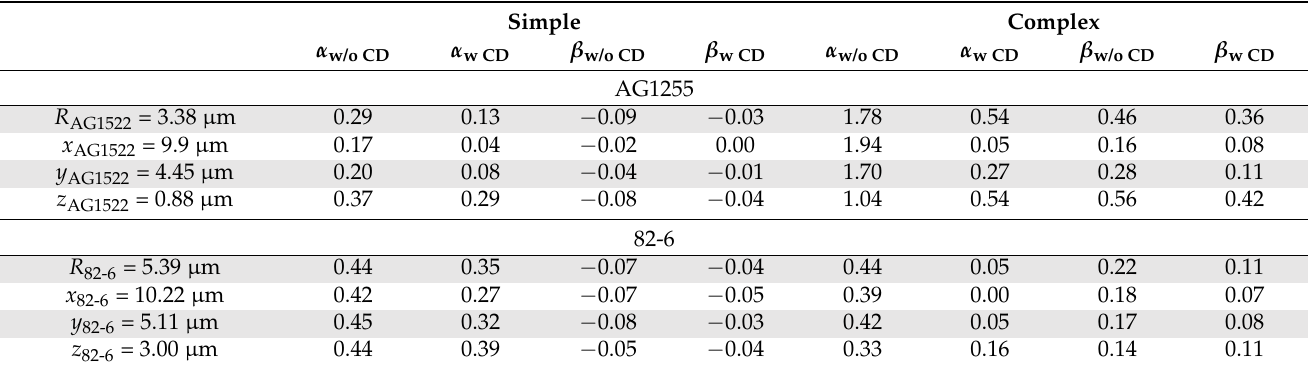
Figure 9. Simple ( a , c ) and complex ( b , d ) exchange dose-responses for two fibroblast cell lines (AG1522 and 82-6) irradiated by a 170 MeV/n Si ion beam. The data points are calculated by RITCARD. The lines represent the best linear quadric fit of the dose-response. The cell line was modeled either as a sphere ( R AG 1522 = 3.38 µ m and R 82 − 6 = 5.39 µ m) or an ellipsoid of equivalent volume and irradiated along the different semi-axes x , y , or z . Solid line with round symbols ( a , c ): without chromosome domain constraint. Dashed line with diamond symbols ( b , d ): with chromosome domain constraint. Table 2. α (Gy − 1 ) and β (Gy − 2 ) coefficients for simple and complex exchanges for spherical and ellipsoidal AG1522 and 82-6 fibroblast nuclei irradiation by 170 MeV/n Si ion beam along the different semi-axes ( R for the spherical shape and x > y > z for the ellipsoidal shape. w/o CD: without chromosome domain constraint; w CD: with chromosome domain